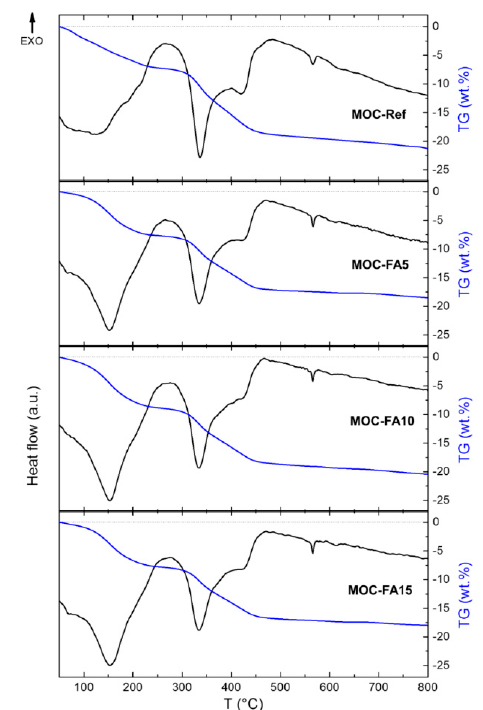
Figure 7. DTA and TG curves of MOC-Ref, MOC-FA5, MOC-FA10, and MOC-FA15.